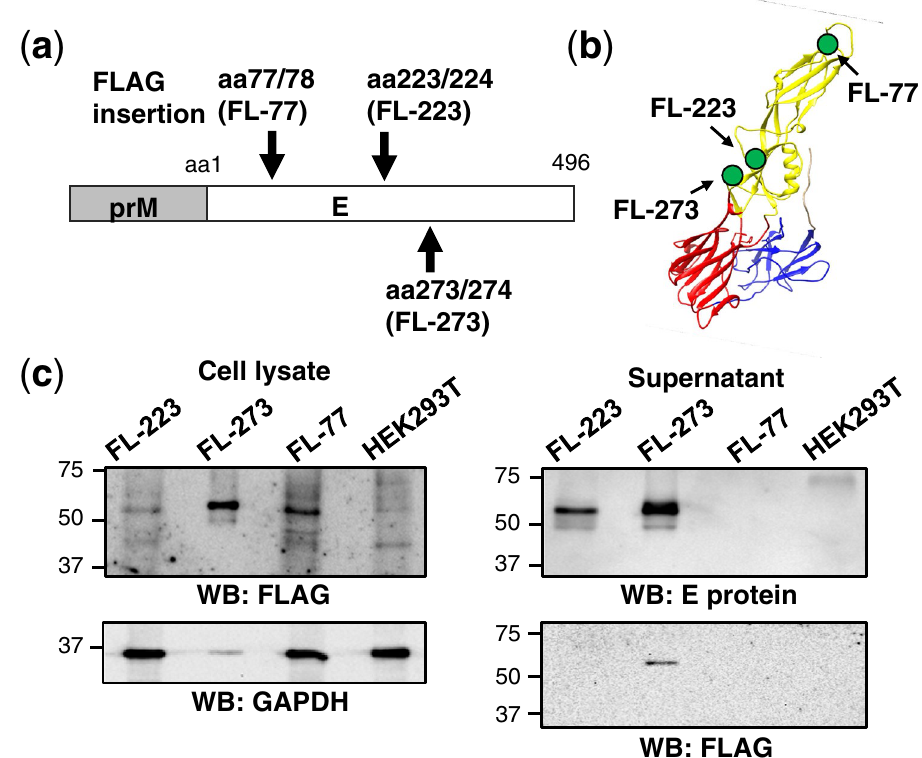
Figure 1. FLAG tag insertion at three positions of DENV E protein domain II in DENV-1 VLP expression plasmid. ( a ) Amino acid positions of FLAG tag insertion in E protein of DENV-1 are shown. ( b ) The 3D structure of DENV-1 E protein (aa 2–404 region) was constructed and three positions of FLAG tag insertion were shown. Circle symbols indicate FLAG tag insertion positions at aa 77/78, 223/224 and 273/274. Three domains in E protein were distinguished in red (domain I), yellow (domain II) and blue (domain III). ( c ) Expression of DENV-1 E protein with FLAG tag insertion from prME plasmids FL-223, -273 and -77 in HEK293T cells (left) and their culture supernatants (right) were compared by western blotting (WB). Monoclonal antibodies against FLAG tag (FLAG), flavi group antigen (E protein), and GAPDH were used as 1st antibodies. Non-transfected HEK293T cell lysate and culture supernatant samples were added as a negative control. Because of difference in expression efficiency among prME plasmids tested, amounts of samples applied for WB which produced from FL-273 were one-hundredth (cell lysate) and one-tenth (supernatant) compared to those from FL-223 and FL-77. The amounts of cell lysates applied were 3 mg for FL-223, FL-77 and HEK293T and 0.03 mg for FL-273. Uncropped images of western blotting pictures are included in supplementary Fig.